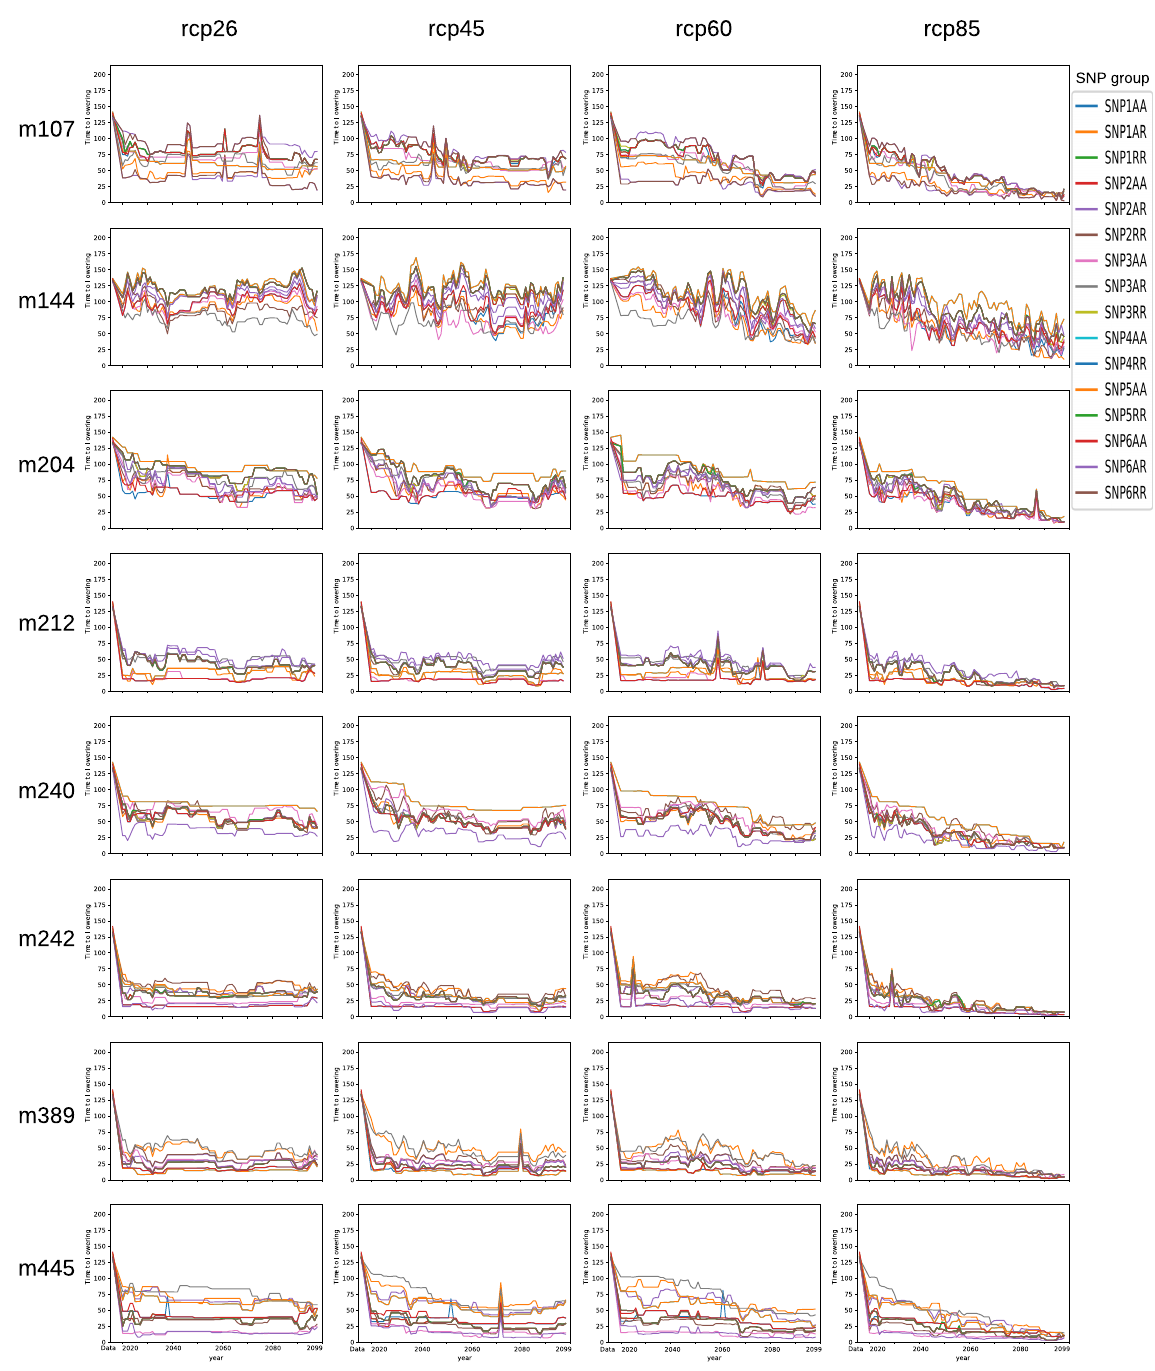
Figure 13. Forecast for time to flowering for SNP groups for years from year 2021 to 2099 in Ankara and for sowing date 294 DOY. Each column corresponds to one representative carbon dioxide concentration profile and each row corresponds to one of the ensemble model. The left-most point for each curve corresponds to the time to flowering in the data